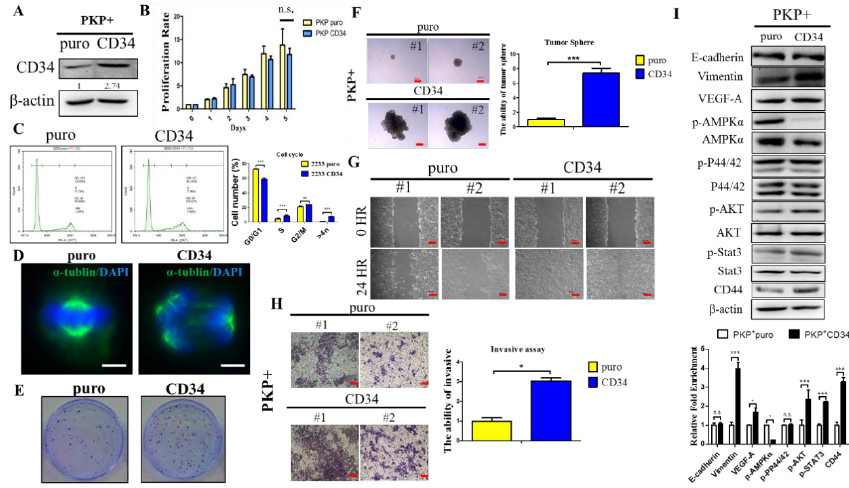
Figure 5. Overexpression of CD34 increases PDAC tumorigenic and migratory abilities. ( A ) Expression levels of CD34 in PKP + pbabe-puro-CD34 and pbabe-puro control cells were determined by Western blotting analysis. ( B ) MTT cell proliferation assays showed that overexpression of CD34 does not affect tumor cell proliferation in vitro. ( C ) Analysis of cell cycle profiles by flow cytometry determined multinuclearity in CD34-overexpressed PKP+ tumor cells. ( D ) CD34-overexpressing PDAC cells exhibited greater than two centrosomes (multinuclearity) as demonstrated by costaining with anti-α-tubulin (red) antibodies and nuclear DAPI (blue). Scale bar is 50 μm. ( E ) Overexpression of CD34 in PKP+ PDAC cells enhanced colony formation according to the colony assay. ( F ) Sphere formation assays determined that overexpression of CD34 significantly increases sphere formation in PKP+ tumor cells; p < 0.001 compared to CD34 with pBabe puro control. ( G ) In vitro cell scratch assays revealed that overexpression of CD34 enhances cell motility in PKP+ PDAC cells. ( H ) Transwell invasion assays showed that CD34 gene overexpression promotes the invasive ability of murine PDAC cells; p < 0.01 compared to CD34 with pBabe puro control. ( I ) Overexpression of CD34 in PKP + PDAC cells increased expression of p-AKT, p-STAT3, EMT markers, and CD44 protein, but downregulated the protein level of p-AMPK α according to Western blot analysis. Densitometric analysis of relative expression levels after normalization to loading control β -actin are presented in the lower panel. * p < 0.05; *** p <